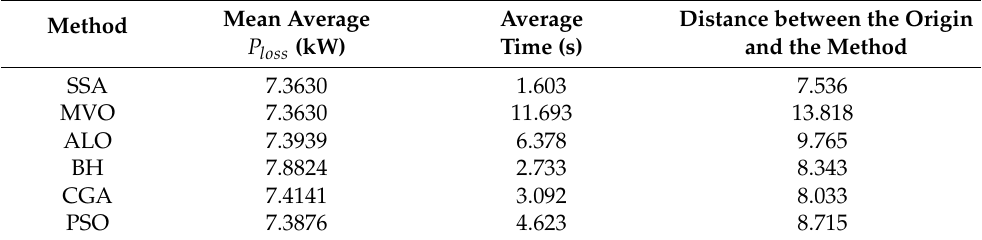
Table 6. Mean average power losses vs. average time in the 21-node system.